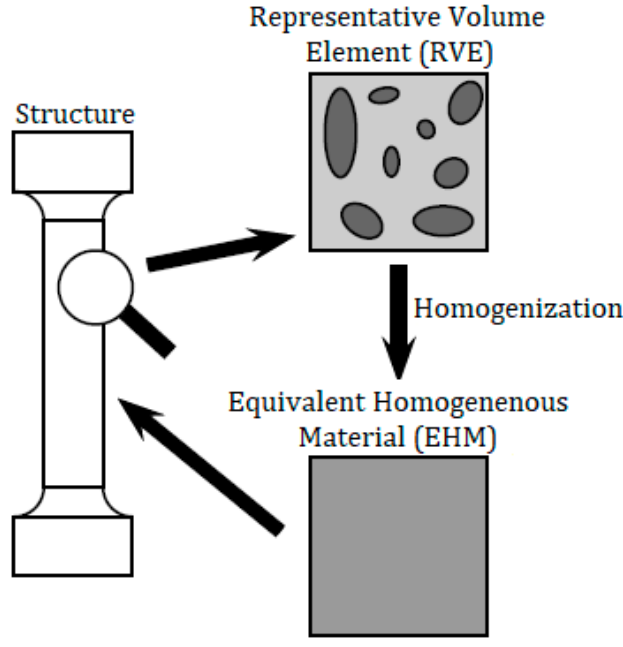
Figure 2. Illustration of the homogenization technique.